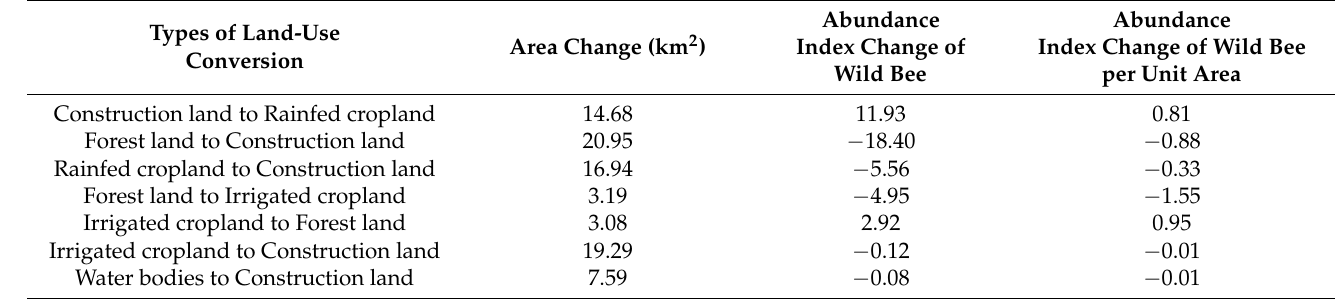
Table 6. Correlation between land-use conversion and the change in wild bee abundance index for litchi and longan in the buffer zone from 2015 to